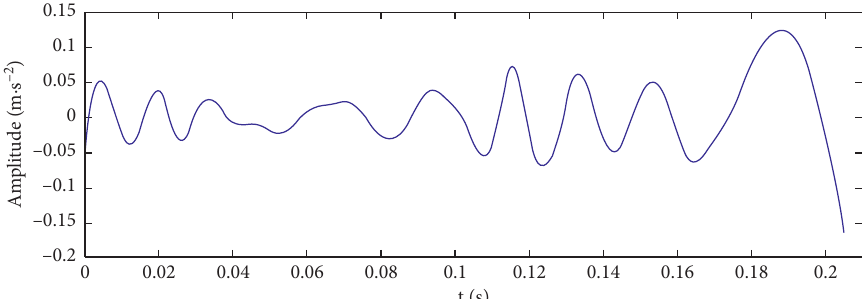
Figure 9: Time-domain waveform of sensitive IMF component by the EEMD